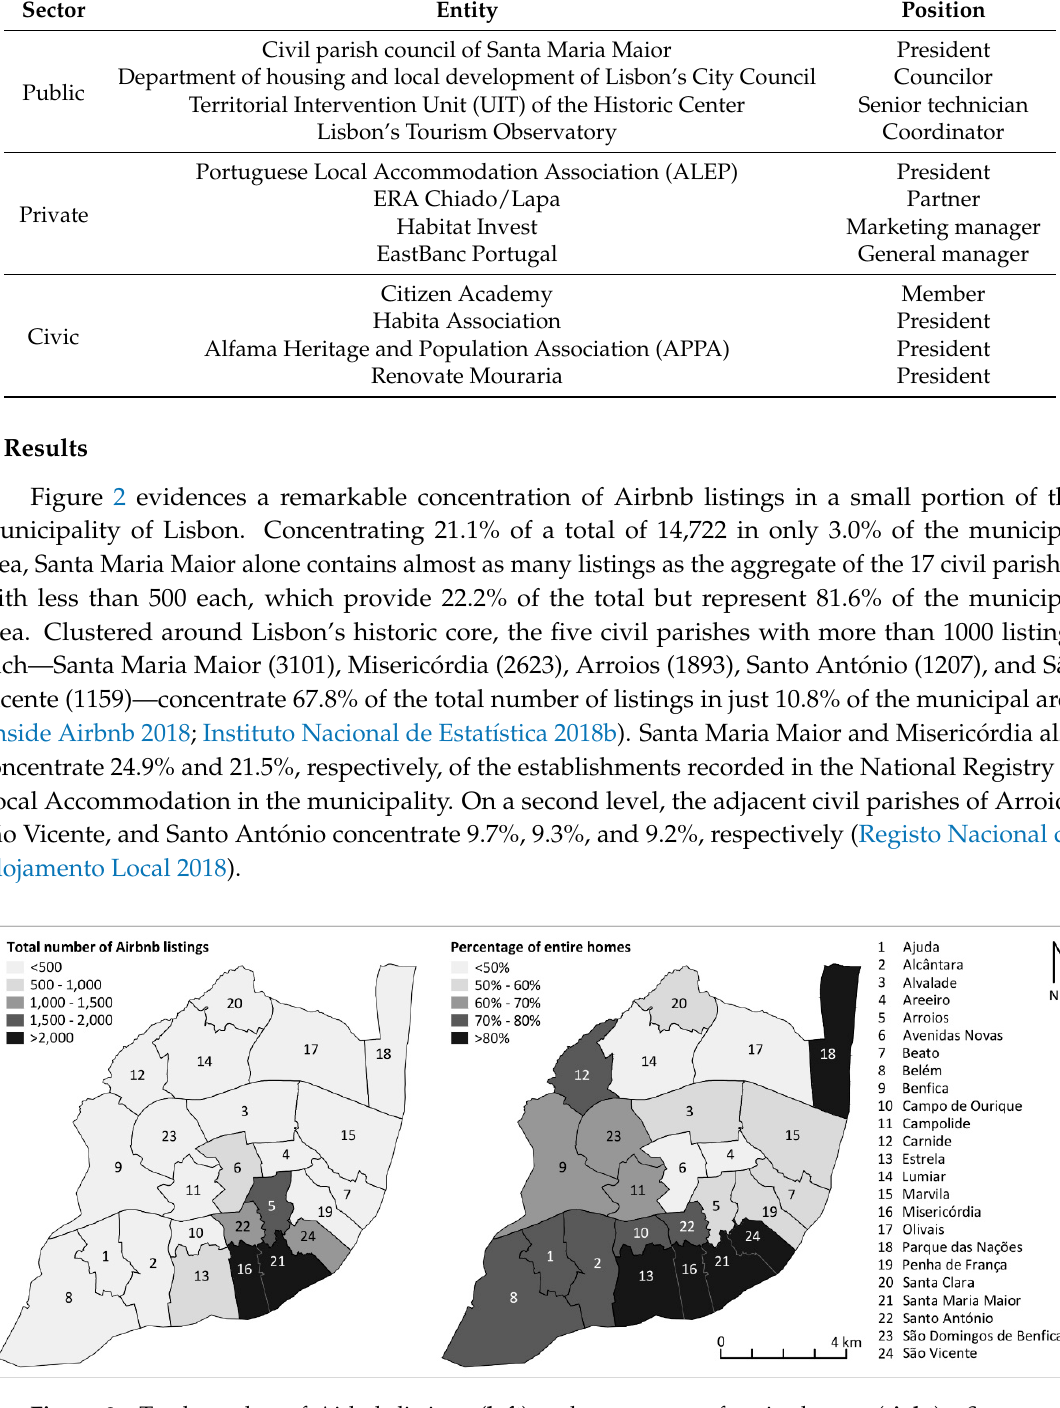
Figure 2. Total number of Airbnb listings ( left ) and percentage of entire homes ( right ). Source : Own elaboration based on data from Inside Airbnb (2018).